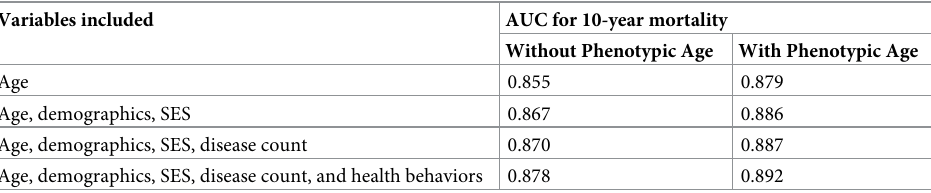
Table 2. AUC for 10-year mortality for combinations of variables. Variables included AUC for 10-year mortality Without Phenotypic Age With Phenotypic Age Age 0.855 0.879 Age, demographics, SES 0.867 0.886 Age, demographics, SES, disease count 0.870 0.887 Age, demographics, SES, disease count, and health behaviors 0.878 0.892 The AUC for Phenotypic Age alone was 0.879. Demographic variables included race/ethnicity and sex. SES refers